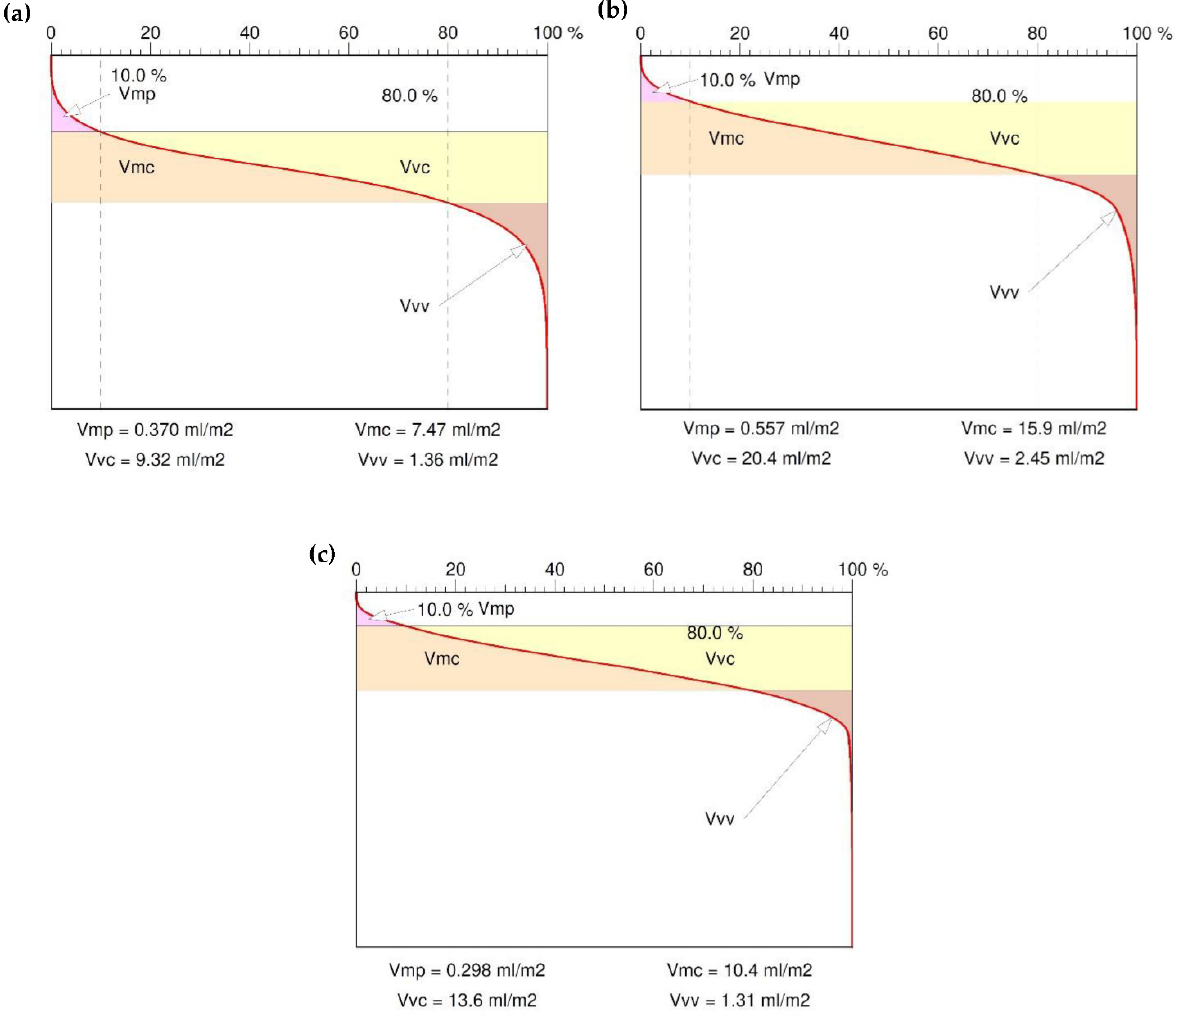
Figure 14. Abbott–Firestone curve (bearing area curve), surface volumetric functional parameters—( a ) 100% resin, ( b ) 5% resin and 95% brass, ( c ) 5% resin and 95% aluminum.